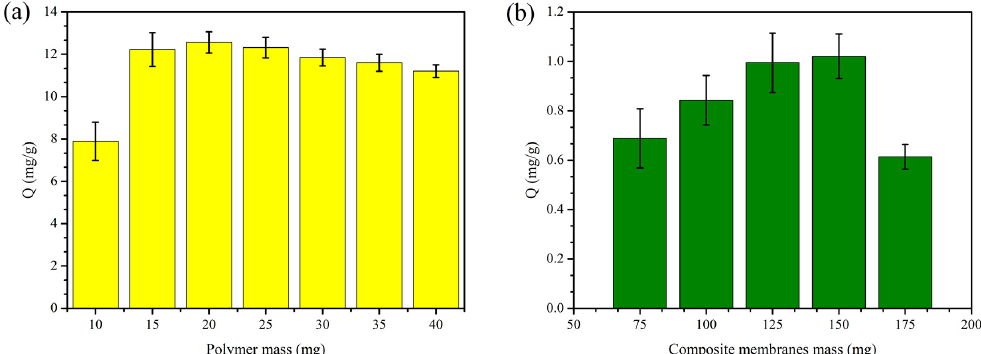
Figure 5. Adsorption of dencichine on different mass RCMs and RPMs; ( a ) RPM adsorption amount; ( b ) RCM adsorption amount.